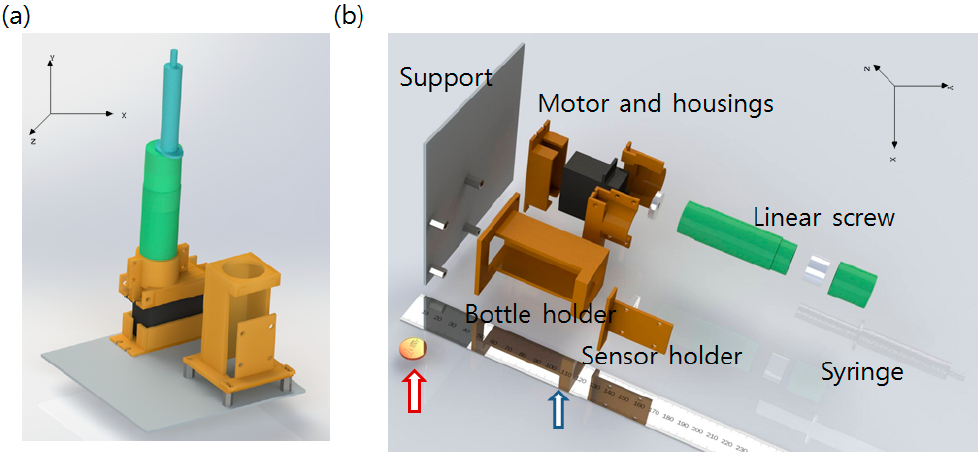
Figure 2. ( a ) Designed hardware component. Orange colored parts are 3D-printed. Empty space at the left side is reserved for the circuit; ( b ) Exploded view of the hardware system describing how the components are assembled. A centimeter scale ruler (Blue arrow) and one cent (Red arrow) coin are added in the image for scale comparison.